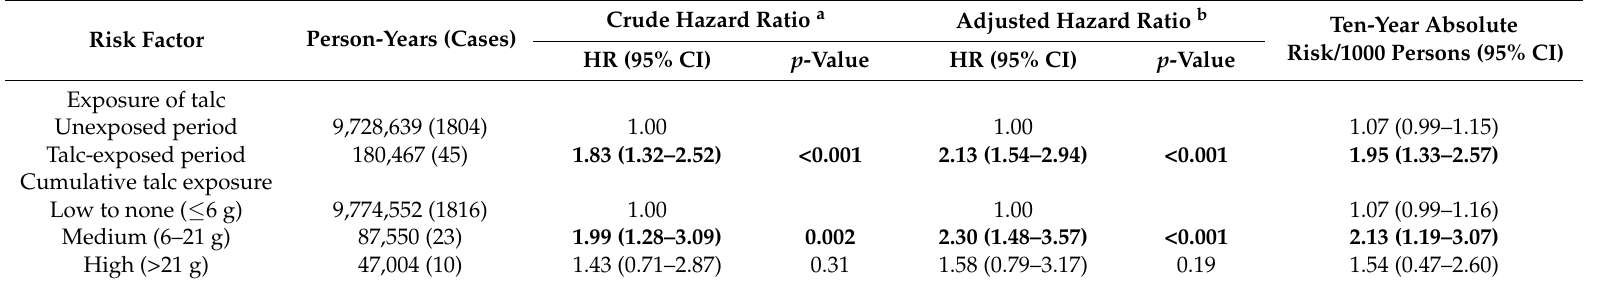
Table 3. Hazard ratio of stomach cancer by talc